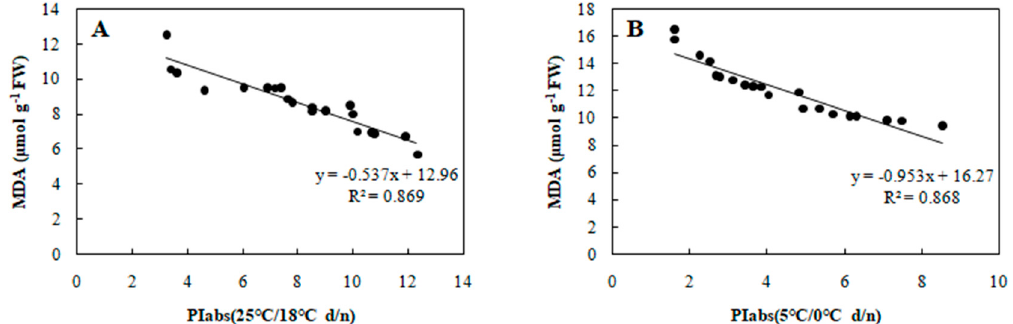
Figure 6. Correlation between PIabs and MDA in 20 wucai genotypes measured in ( A ) 25/18 °C (d/n) treatment and ( B ) 5/0 °C (d/n) treatment.